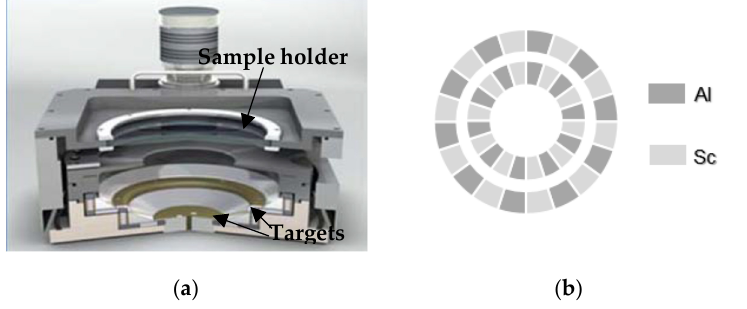
Figure 1. ( a ) Cross-sectional diagram of the sputtering chamber. ( b ) Coaxial Al-Sc segmented targets.